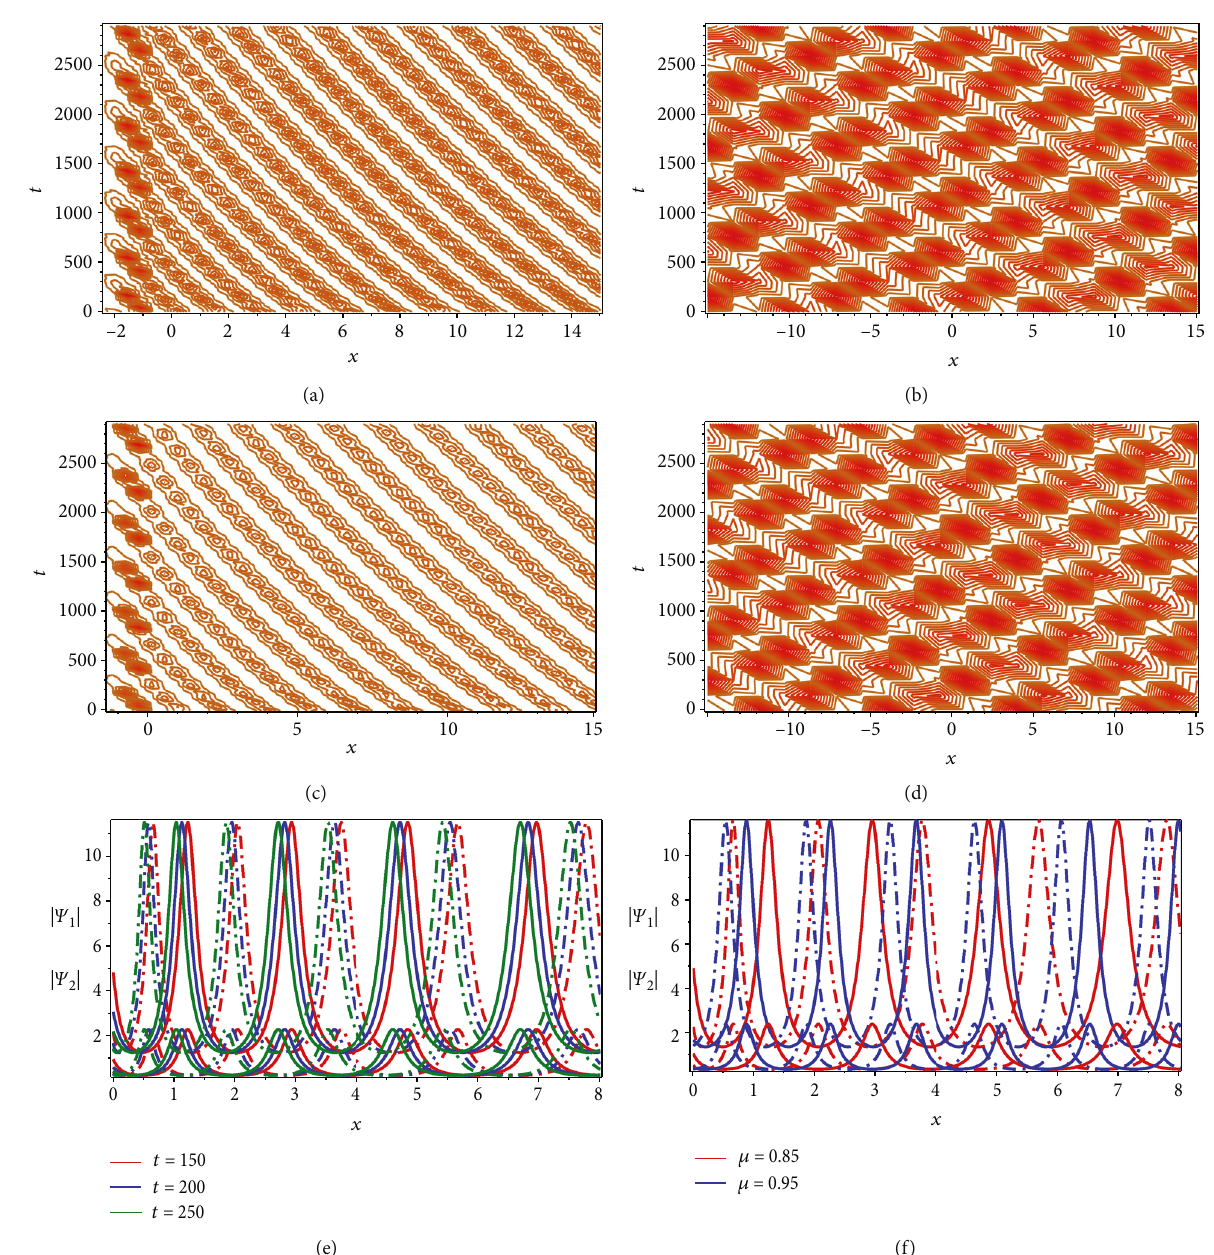
x , t Þj of Equation (26) for (a) μ = 0 : 9 and (b) μ = 1 for BFD, (c) μ = 0 : 9 and (d) μ = 1 for CFD, and 2D wave Figure 2: Contour plots of j Ψ 1 ð pro fi le (Solid line=BFD; Dash Line =CFD) of the e ff ect of (e) time for μ = 0 : 75 and (f) fractional parameter μ for t = 150 . The remaining parameters are as in Figure